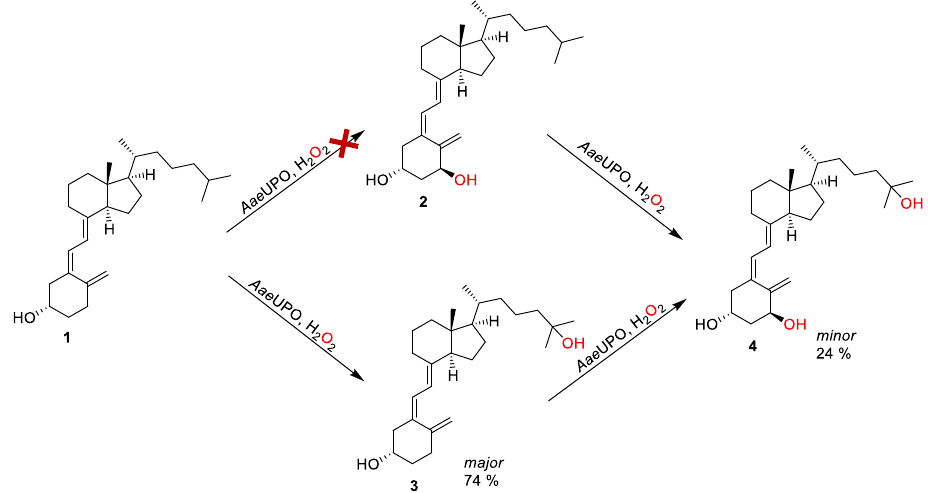
Figure 3. Synthesis of calcitriol starting from vitamin D3 via the formation of either alfacalcidol or 25-hydroxyvitamin D3 as intermediate. Conditions: [ Aae UPO] = 2.5 µ M, [vitamin D3] = 2.5 mM, NaPi buffer (50 mM, pH 6), 40% ( v / v ) acetone, [H 2 O 2 ] = 1.0 mM h − 1 , 24 h, 25 ◦ C, 1 mL.